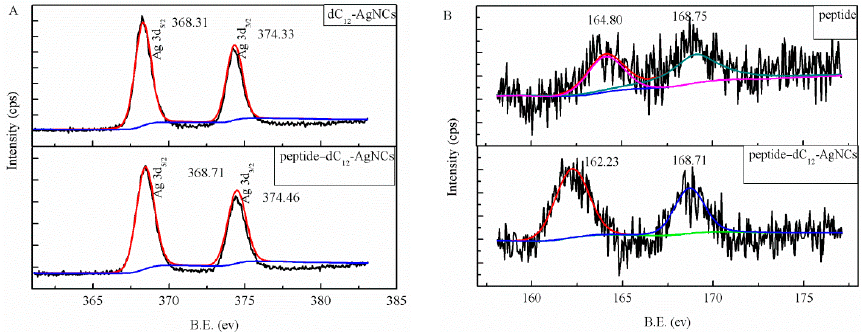
Figure 2. XPS spectrum of Ag 3d of dC 12 -AgNCs and dC 12 -AgNCs − peptide ( A ); XPS spectrum of S2p of peptide and dC 12 -AgNCs-peptide ( B ).